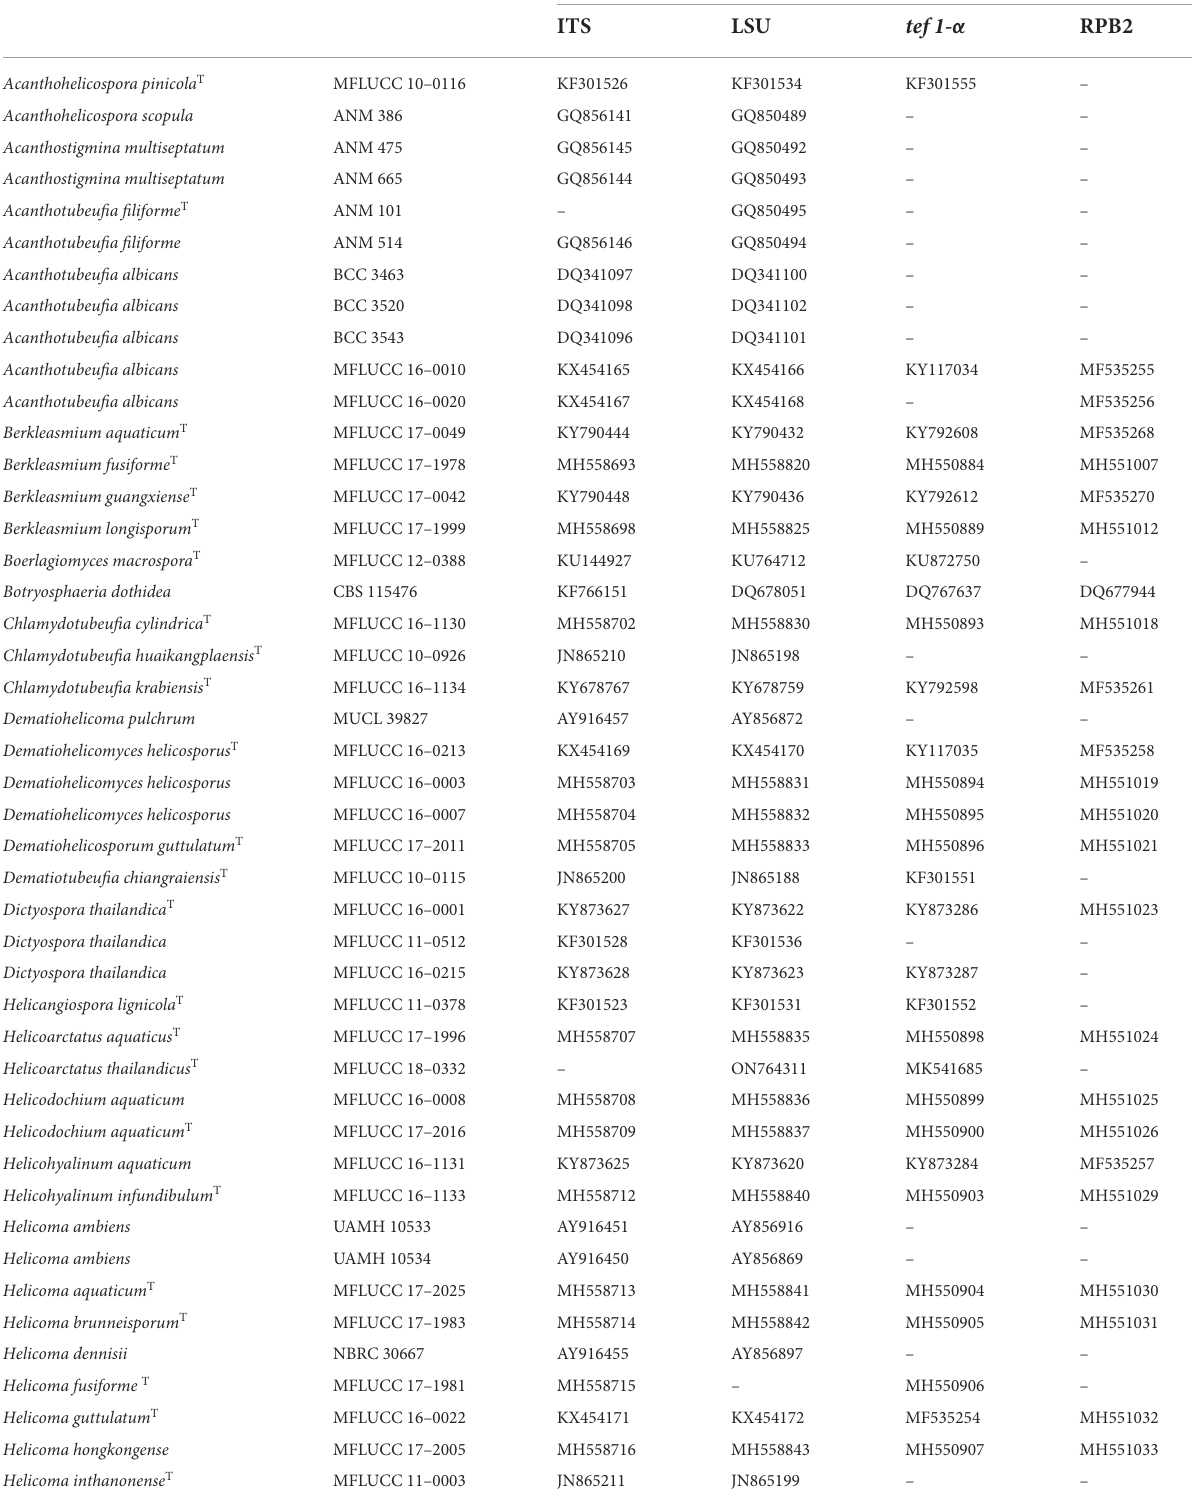
TABLE 1 GenBank numbers and culture collection accession numbers of species included in the phylogenetic